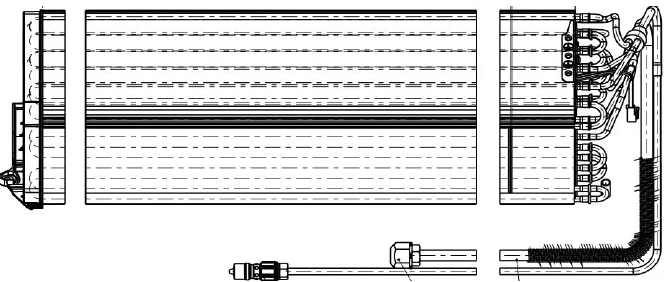
Figure 4. Plane diagram of the evaporator.